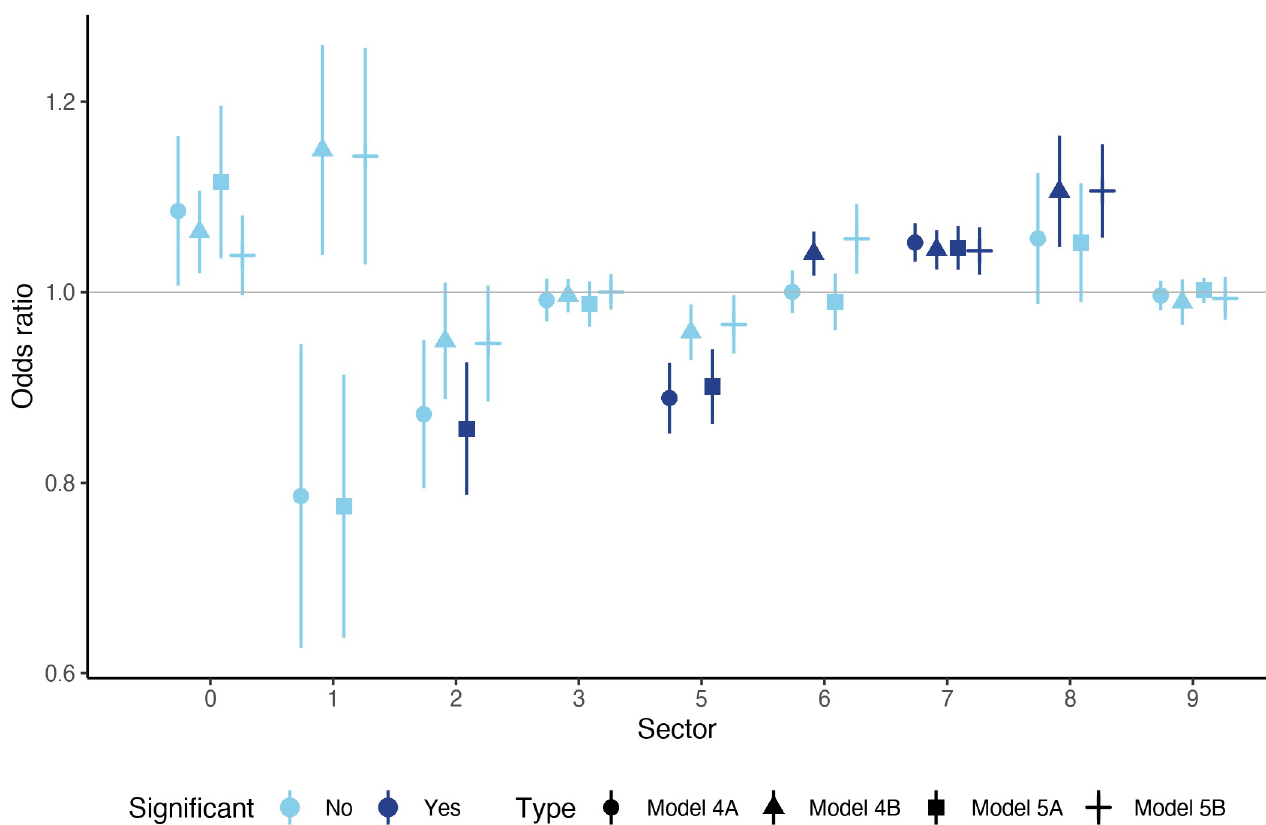
Fig 7. Results of Model 4A, 4B, 5A and 5B for the downstream variables. Every marker/line represents the estimated odds-ratio of a given sector in a given model type, measured on the vertical axis. The shape of the markers shows the model type. Circles represent estimated odds-ratios in Model 4A, where every sector is included simultaneously, plus the control variables. Triangle markers indicate the estimated odds-ratios in Model 4B, where sectors enter one-by-one. Squares show the estimated odds-ratios in Model 5A, where sectors enter simultaneously together with upstream connections (all sectors). Horizontal line markers show the estimated odds-ratios in Model 5B, where sectors enter individually, together with their respective upstream counterparts. Dark blue markers/lines show significant odds-ratios at the 10% level, light blue markers/colors represent non-significant results. The length of the vertical lines refer to the robust standard errors around the point-estimates. Sectors are grouped along the horizontal axis, marked by their codes (see Table 1 for reference).